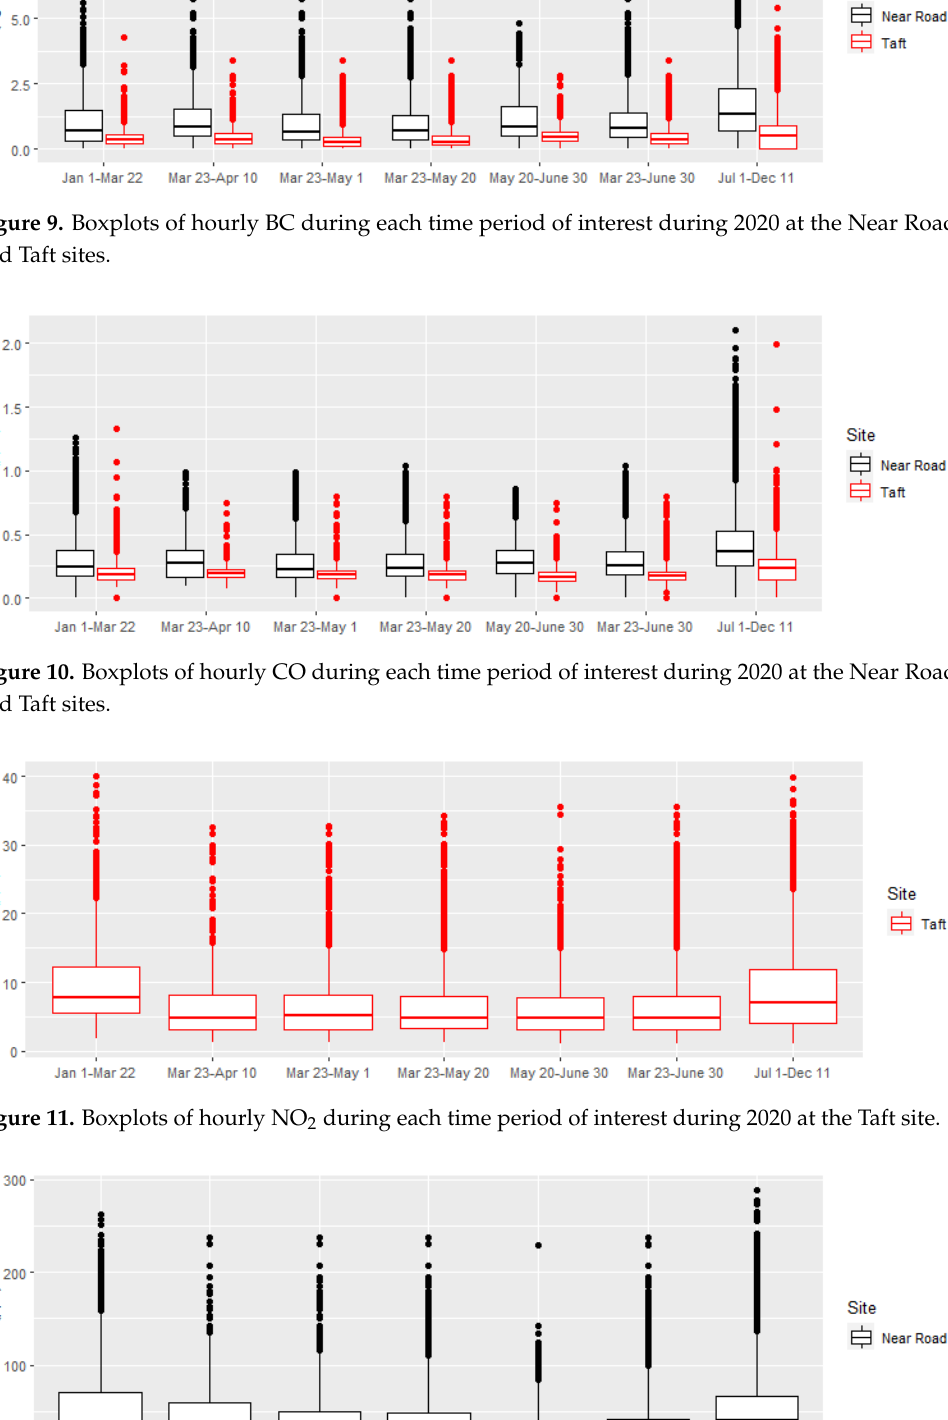
Figure 13. Boxplots of hourly O 3 during each time period of interest during 2020 at the Taft site.